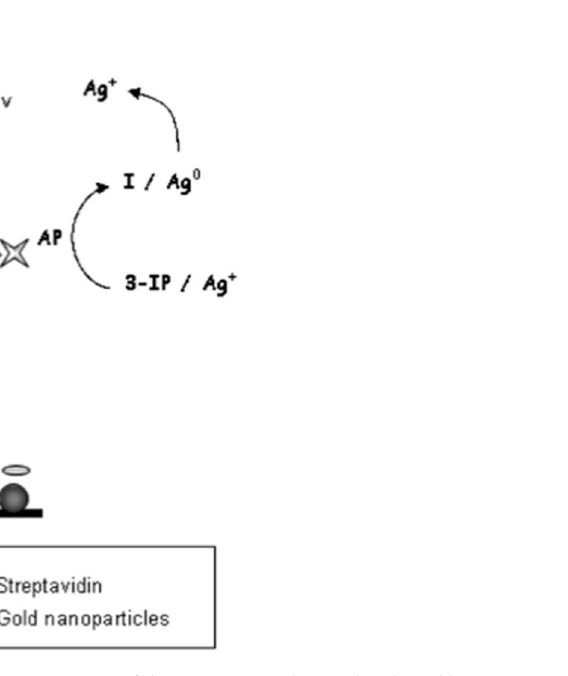
Figure 4. Basic schematic representation of the genosensor device developed by Martinez-Paredes et al.